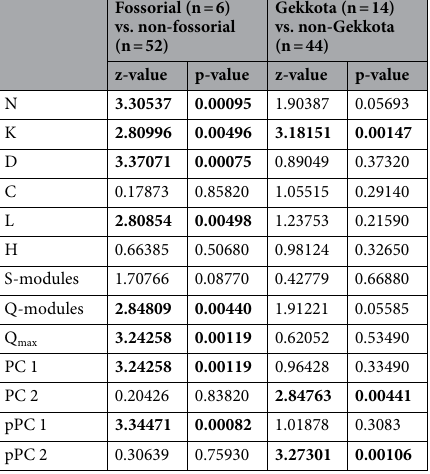
Table 1. Comparison of network parameters and principal components scores using the Mann–Whitney U test. Values with significant differences are shown in